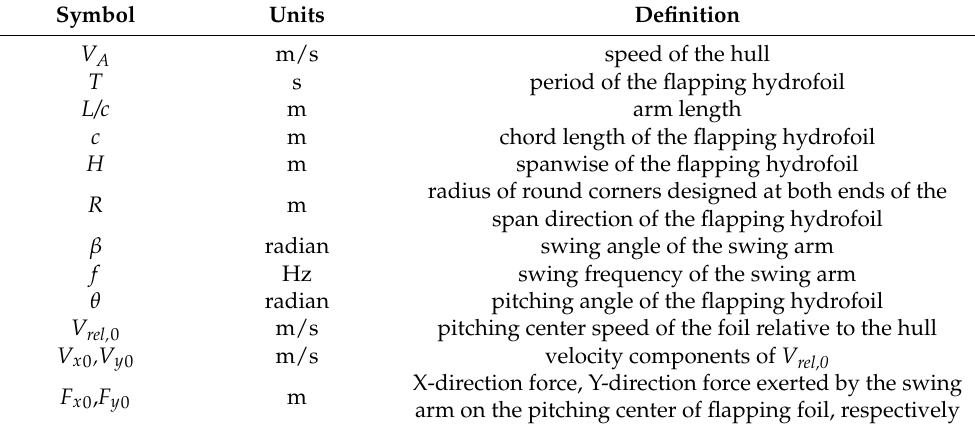
Table 1. Parameters of the semi-active flapping hydrofoil with arc